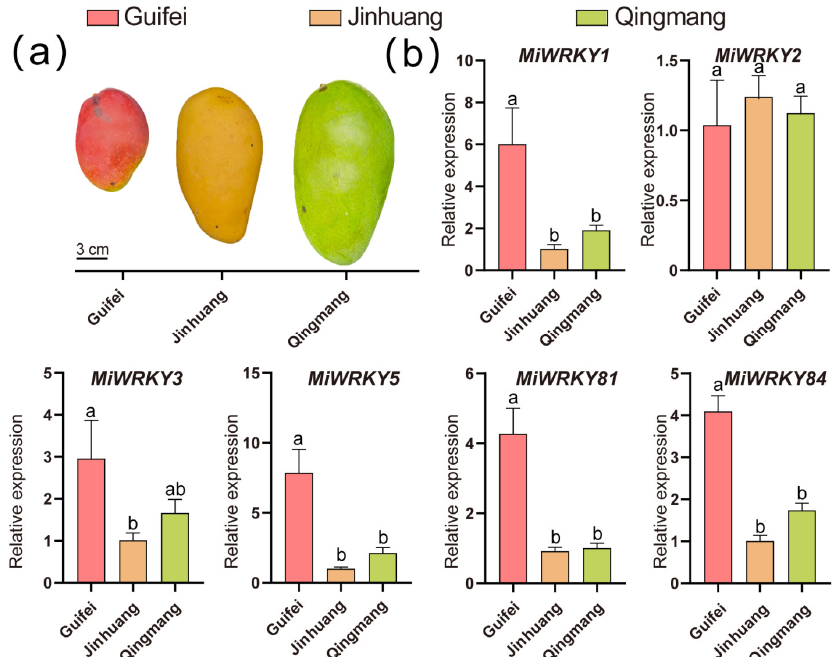
Figure 9. ( a ) Phenotypes of three mango cultivars, including ‘Guifei’ (red skin), ‘Jinhuang’ (yellow skin), and ‘Qingmang’ (green skin). ( b ) Expression levels of MiWRKY genes in ‘Guifei’, ‘Jinhuang’, and ‘Qingmang’ fruit skin. The data represents the mean ± standard deviation with n = 3. Different letters above bars denote significant difference at p < 0.05.